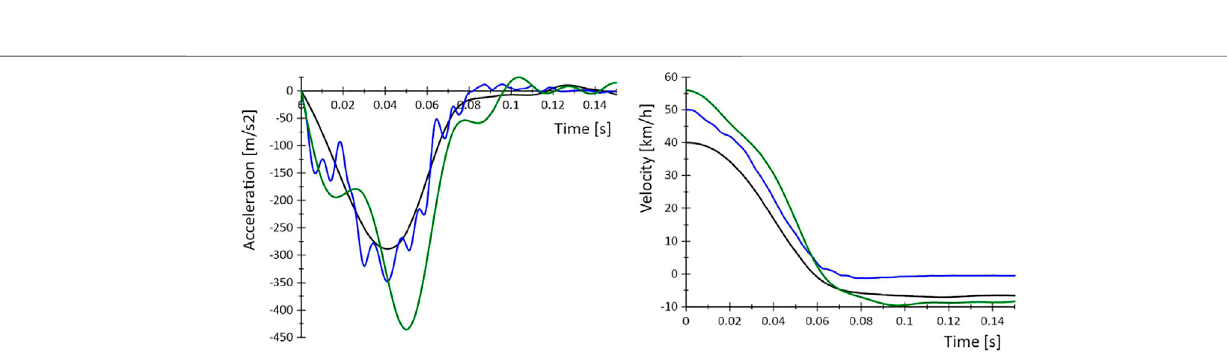
Frontiers in Future Transportation |